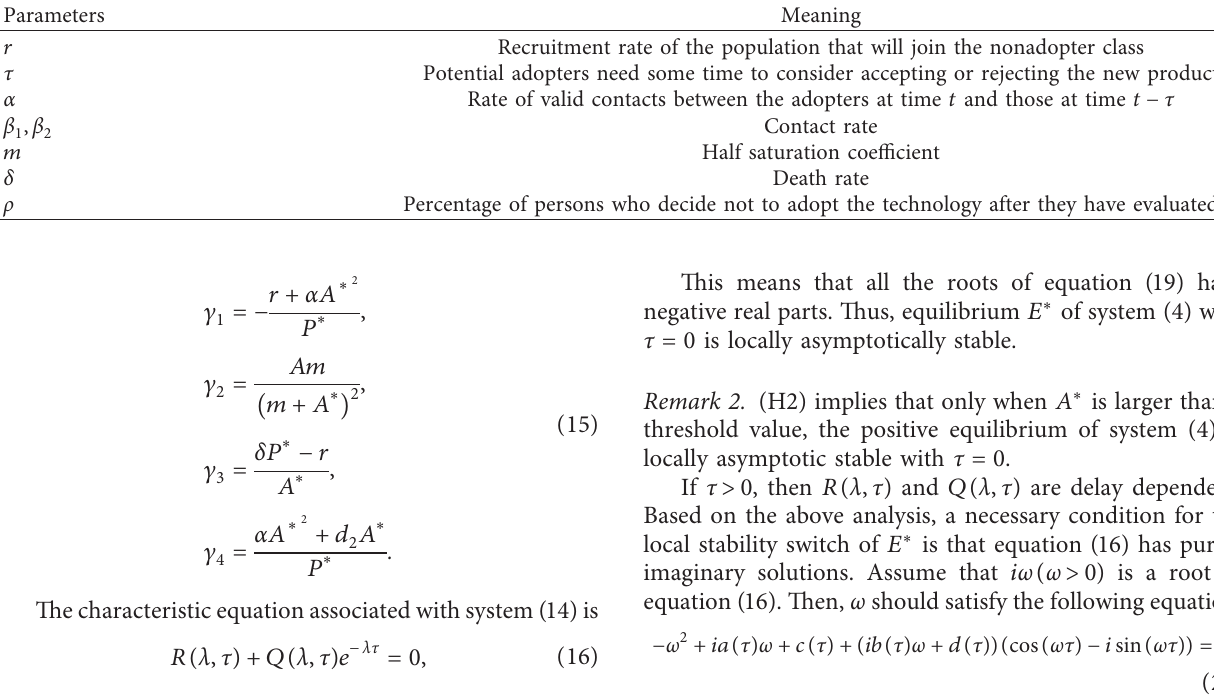
Table 1: Meaning of the